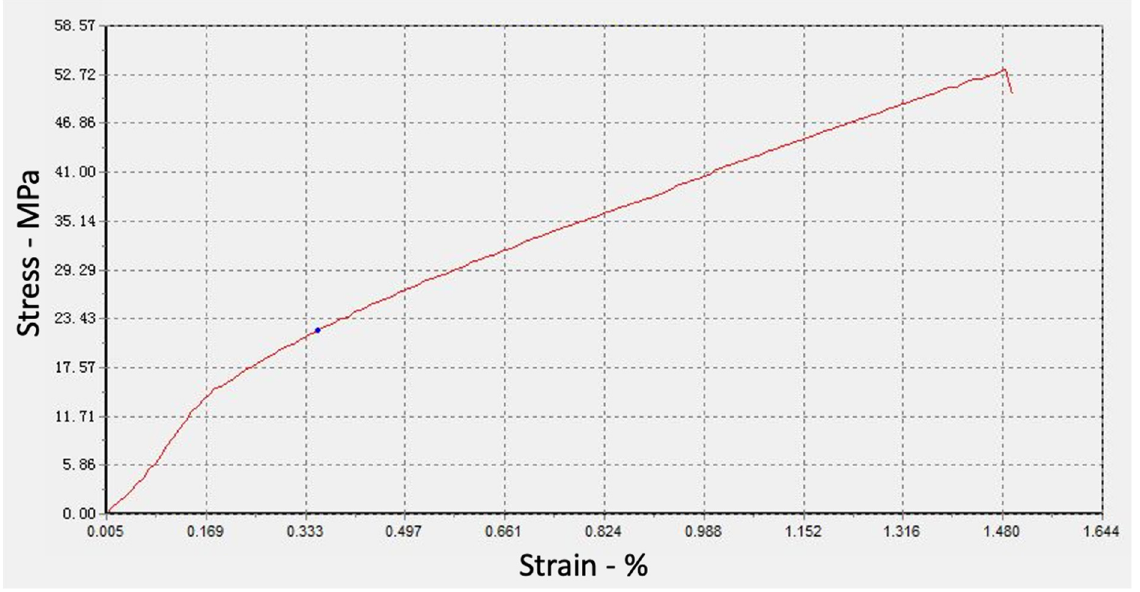
Figure 3. Typical engineering stress-strain curve of SS 316-pure Zn joint (friction time at 35 s, rotation speed at 1450 rpm, friction pressure at 3.9 MPa, and forging pressure at 6.9 MPa).